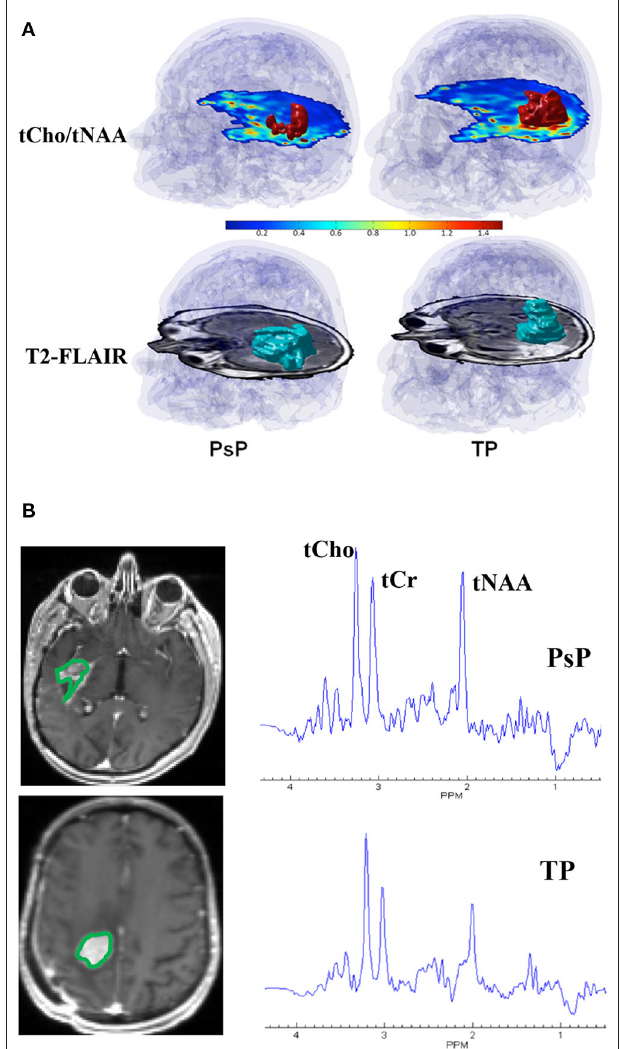
FIGURE 1 | (A) Top Row: tCho/tNAA maps from patients with representative PsP (left) and TP (right) showing red color 3D volumes corresponding to voxels that exceed a threshold value of 0.85 for tCho/tNAA overlaid on the inferior most slices of tCho/tNAA maps encompassing the neoplasm. A transparent blue shows an outline of the brain and skull derived from a coregistered T 1 -weighted MPRAGE image. Bottom Row: T 2 -FLAIR image from these two patients showing blue color 3D volumes corresponding to FLAIR abnormality that is approximately similar in size (227 voxels, 24.4 cm 3 for PsP and 219 voxels, and 23.6 cm 3 for TP). Please note that the red 3D volume of tCho/tNAA is smaller in patients with PsP than patients with TP despite the presence of approximately comparable volumes of FLAIR abnormality, emphasizing the importance of 3D-EPSI in ascertaining the true extent of metabolic abnormalities in patients with TP and PsP. (B) Summed 1 H-MRS spectra encompassing the entire volumes of contrast-enhancing regions of neoplasms from patients with TP and PsP are shown. Please note, higher tCho/tNAA ratio in TP than in